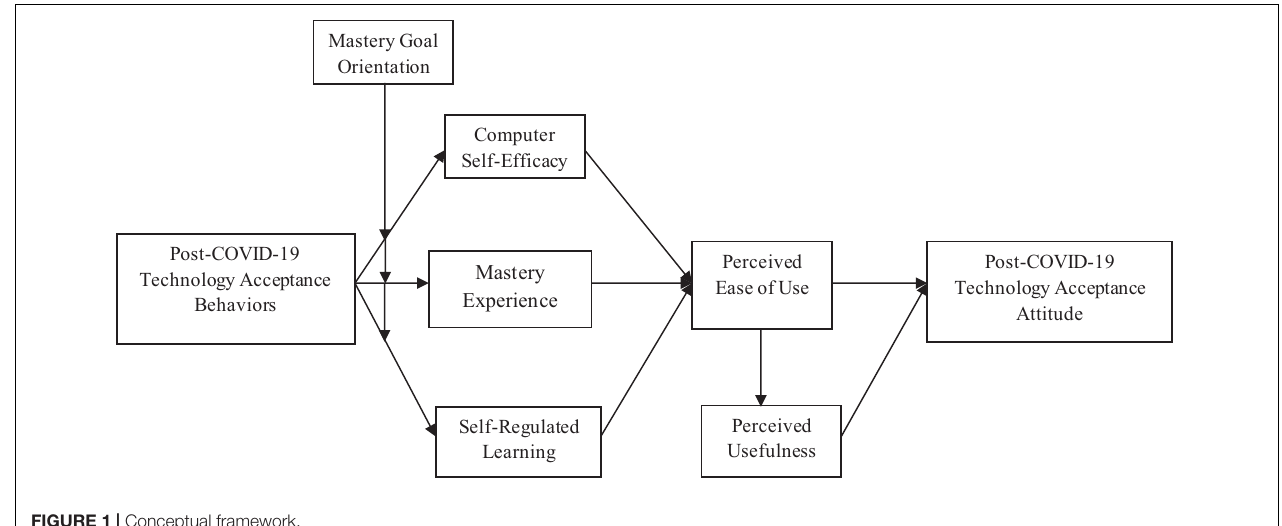
FIGURE 1 | Conceptual